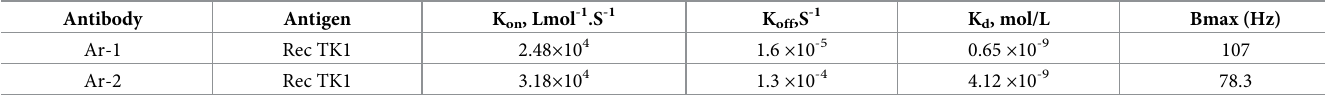
Table 1. Analysis data of antibodies and their kinetics using the Attana QCM-biosensor technology.